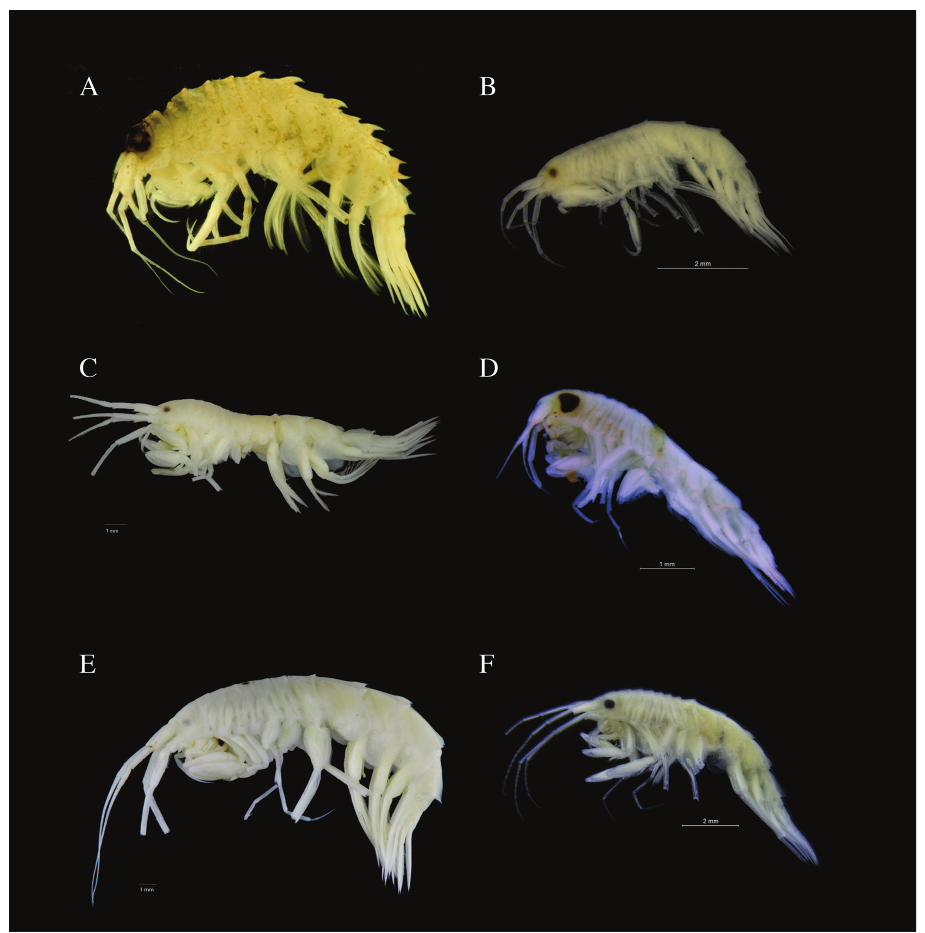
Figure 6. Lateral view photos of NorAmph material representing different clades in the analyses. A Rha- chotropis aculeata AMPNB077-13 B R. helleri AMPNB276-15 C R. aff. helleri AMPNB279-15 D R. aff. inflata AMPNB524-17 E R. lomonosovi AMPNB352-15; F. R. macropus